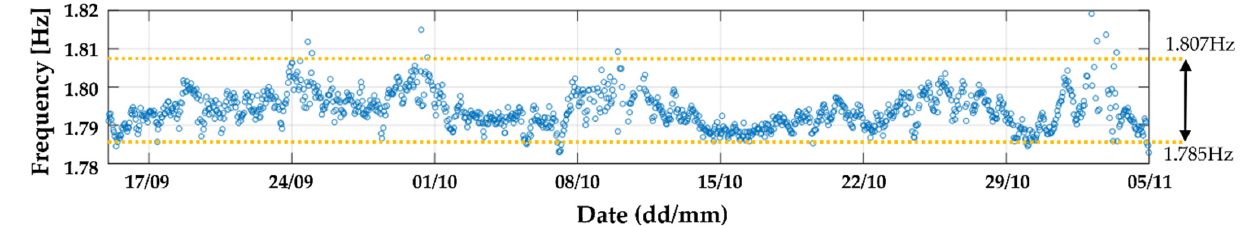
Figure 6. Fluctuation of the first natural frequency of Gageocho ORS [29].